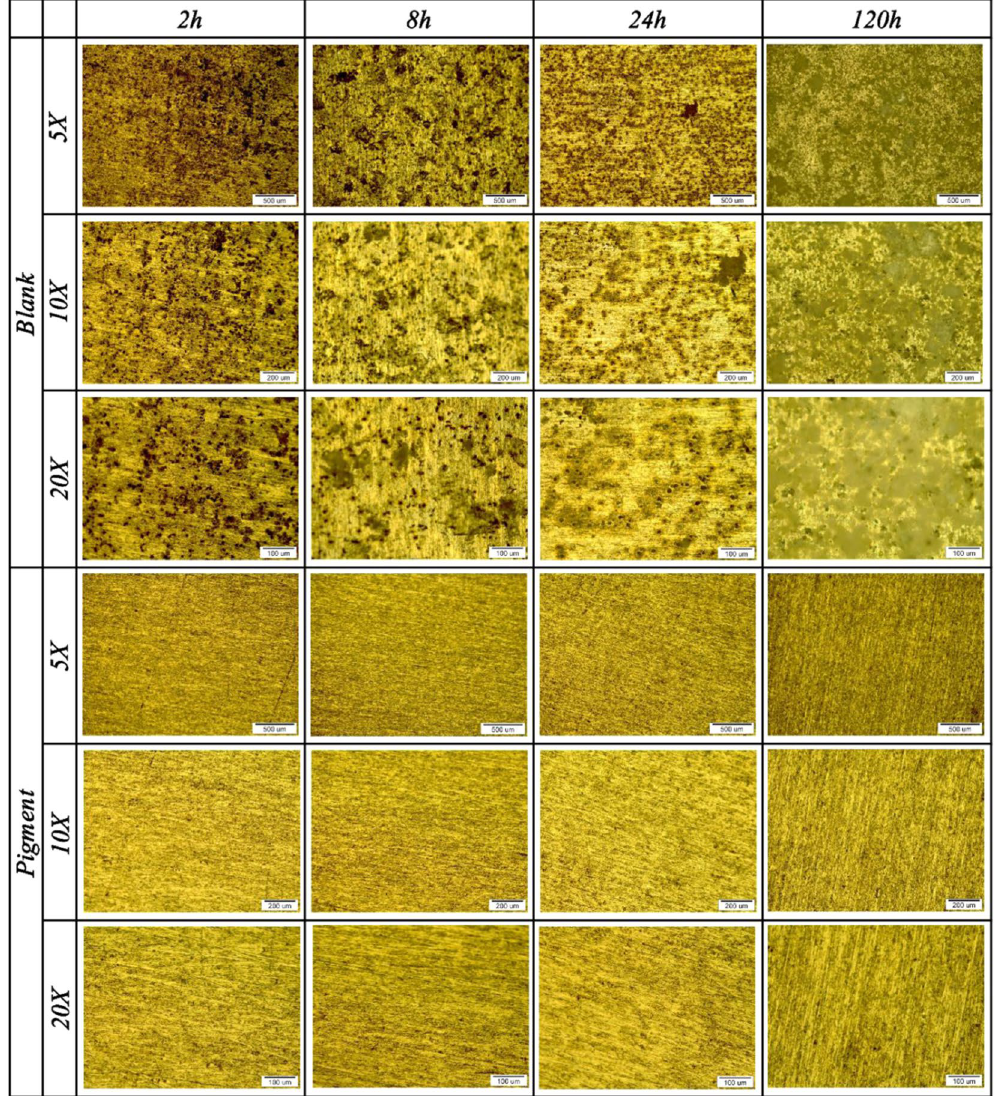
Figure 9. Optical microscopy images for the blank and Ce-DEDTC samples in the various magnifications and immersion